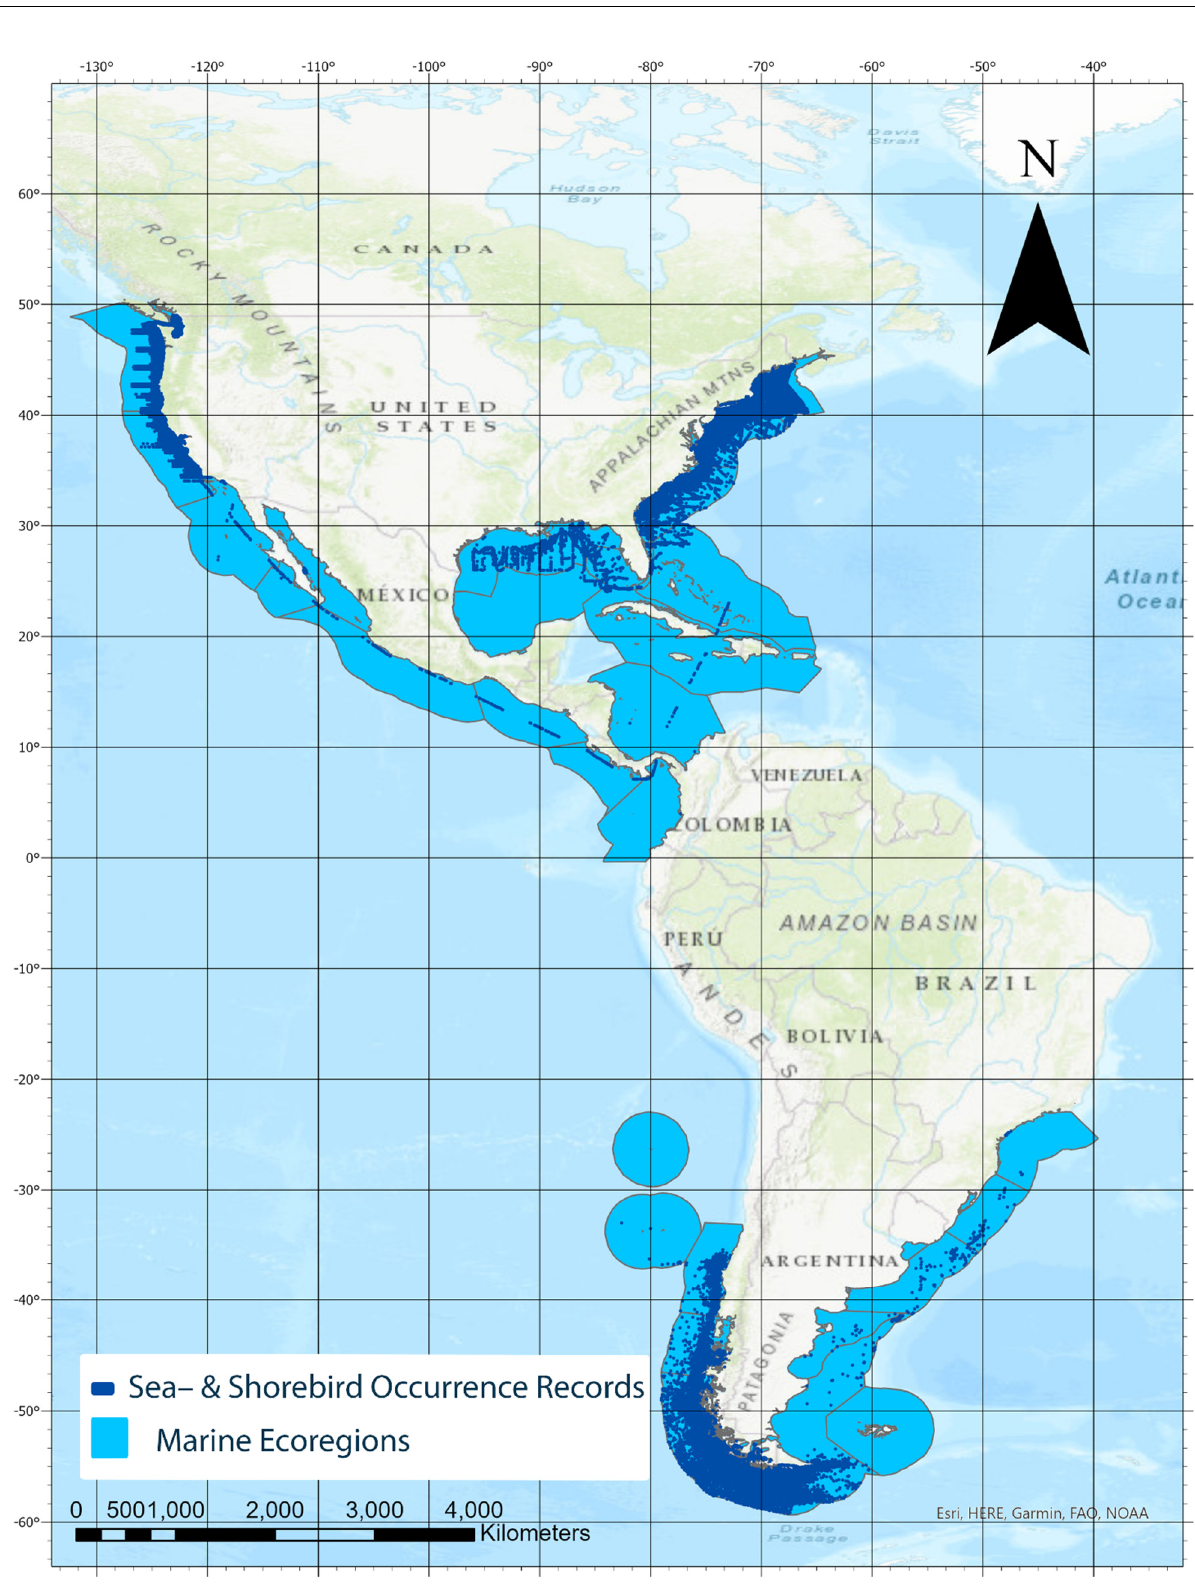
Figure 1. Relevant marine ecoregions of the Americas (based on [14]) used to evaluate sea- and shorebird records found in OBIS ([7]; accessed 7 August 2019). OBIS records found are noted by blue dots, and all marine ecoregions and occurrence records are located off the coast. Marine ecoregions where no seabird records were found in OBIS are not shown. Dashed line along western Central America and across to the Caribbean Sea indicate that observations were recorded along a cruise track